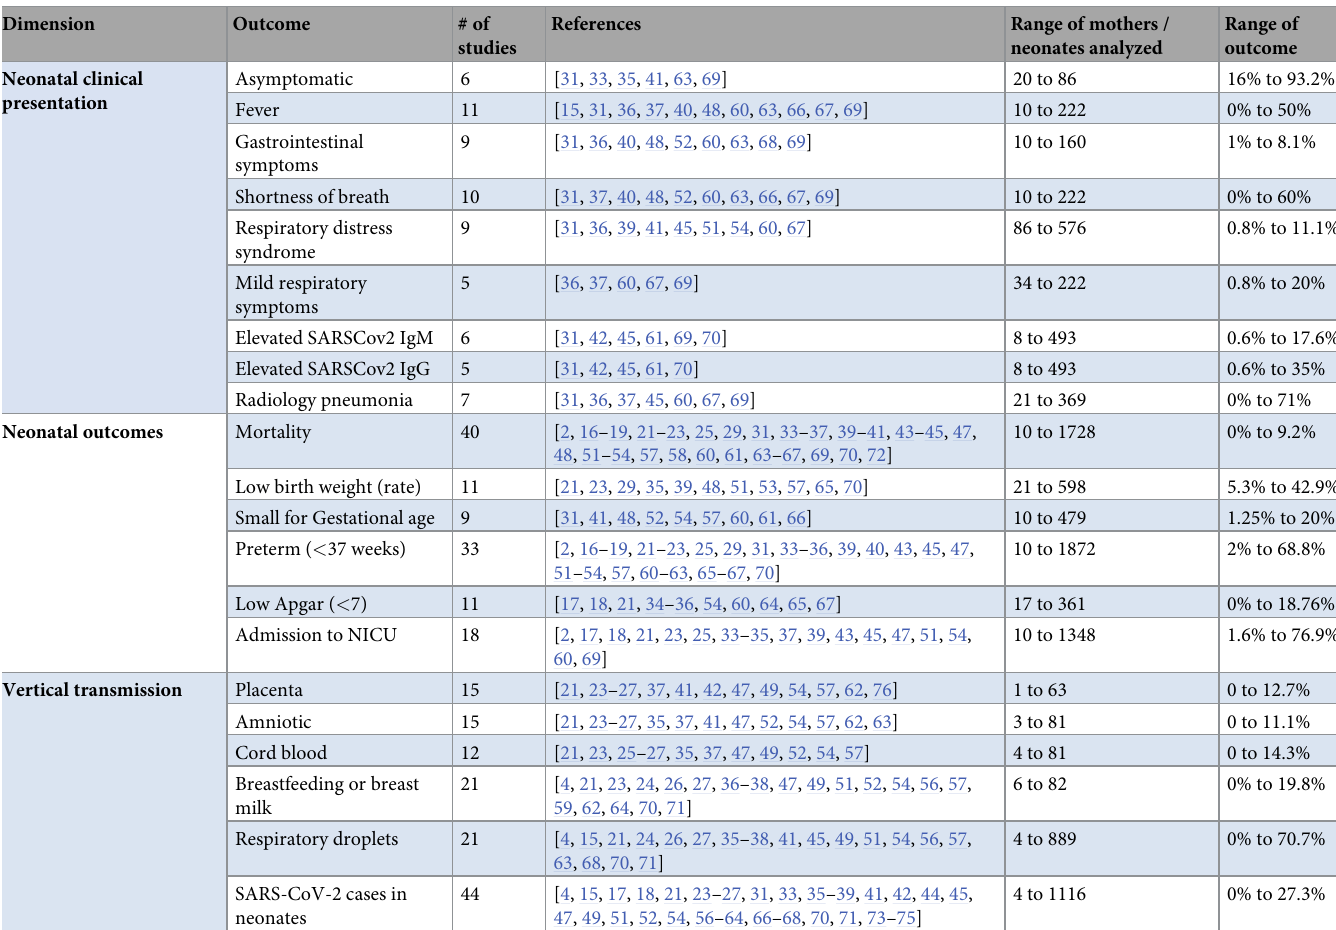
Table 6 in S8 File ). Most studies only reported the proportion of infants’ positive cases without evaluating breast milk or congenital/perinatal transmission. In the reviews reporting breast milk or congenital/perinatal transmission the sample analyzed was generally small for these